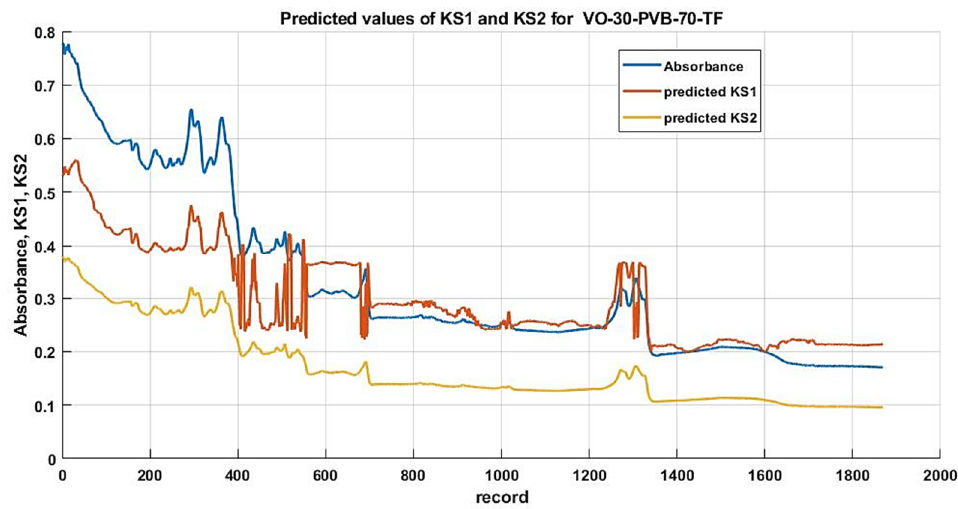
Figure 10. Graphic representation of the predicted values of KS1 and KS2 [authors’ own processing]. Table 3. Predicted values of KS1 and KS2 for VO_30_70_PVB_TF [authors own processing]. Values Absorbance 0.774 0.778